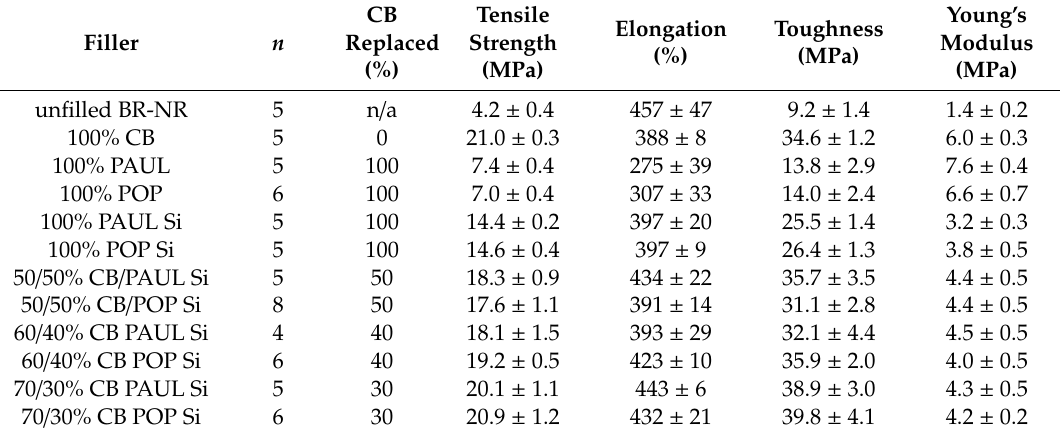
Table 4. Tensile Properties of Rubber Composite Samples.